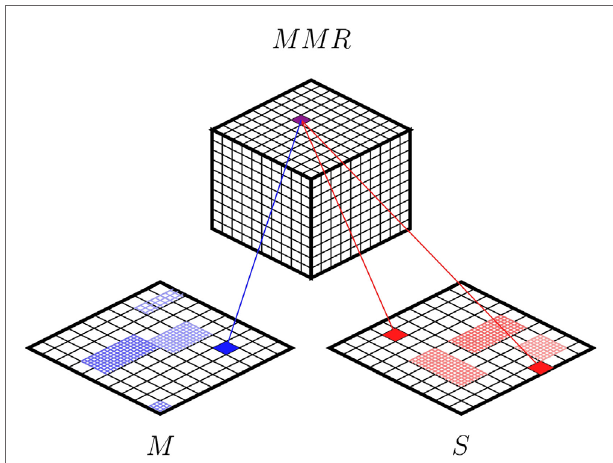
FigUre 2 | self-organized internal models architecture (sOiMa) . Two modality maps are shown representing M and S . The map at the top integrates the modalities coding, thus, sensory–motor schemes in a Multi-Modal Representation ( MMR